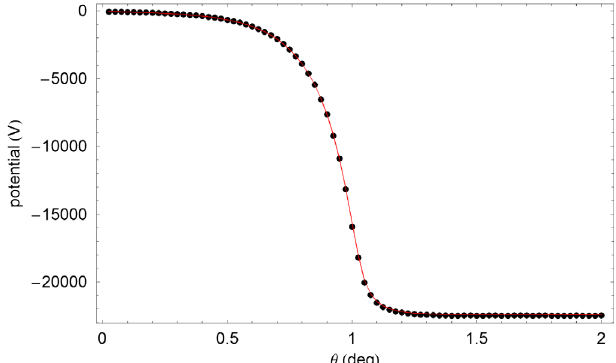
9. Scalar potential in an electrostatic quadrupole in the g − 2 storage ring. The potential is plotted as a function of toroidal coordinate v at θ ¼ 2 ° (left) and at θ ¼ 0 . 25 ° (right), with u ¼ u lines show fits using